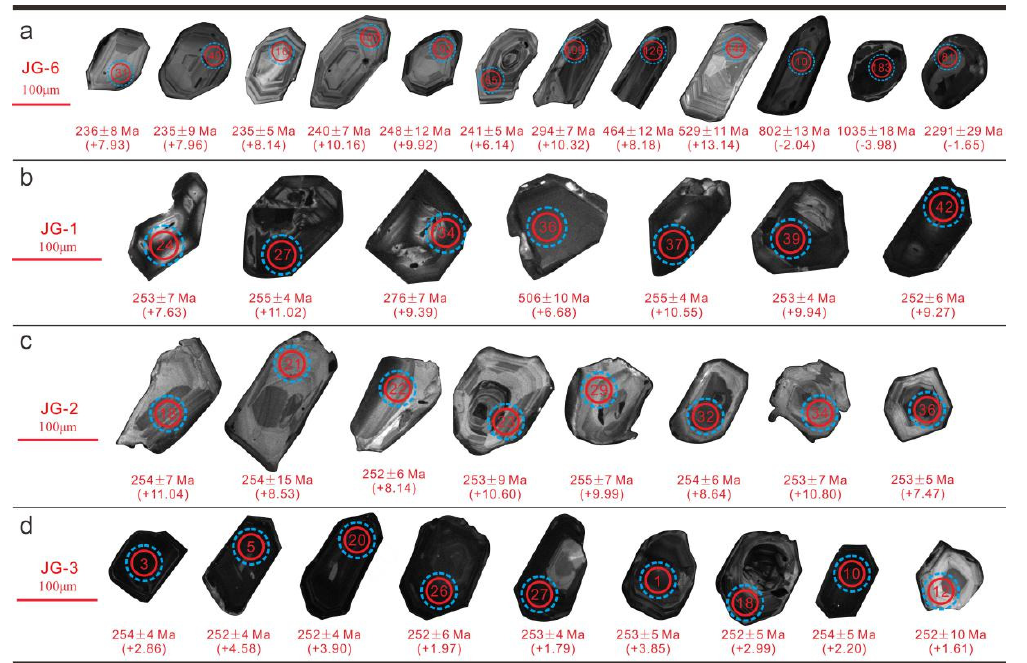
Minerals 2021 , 11 , x FOR PEER REVIEW 6 of 19